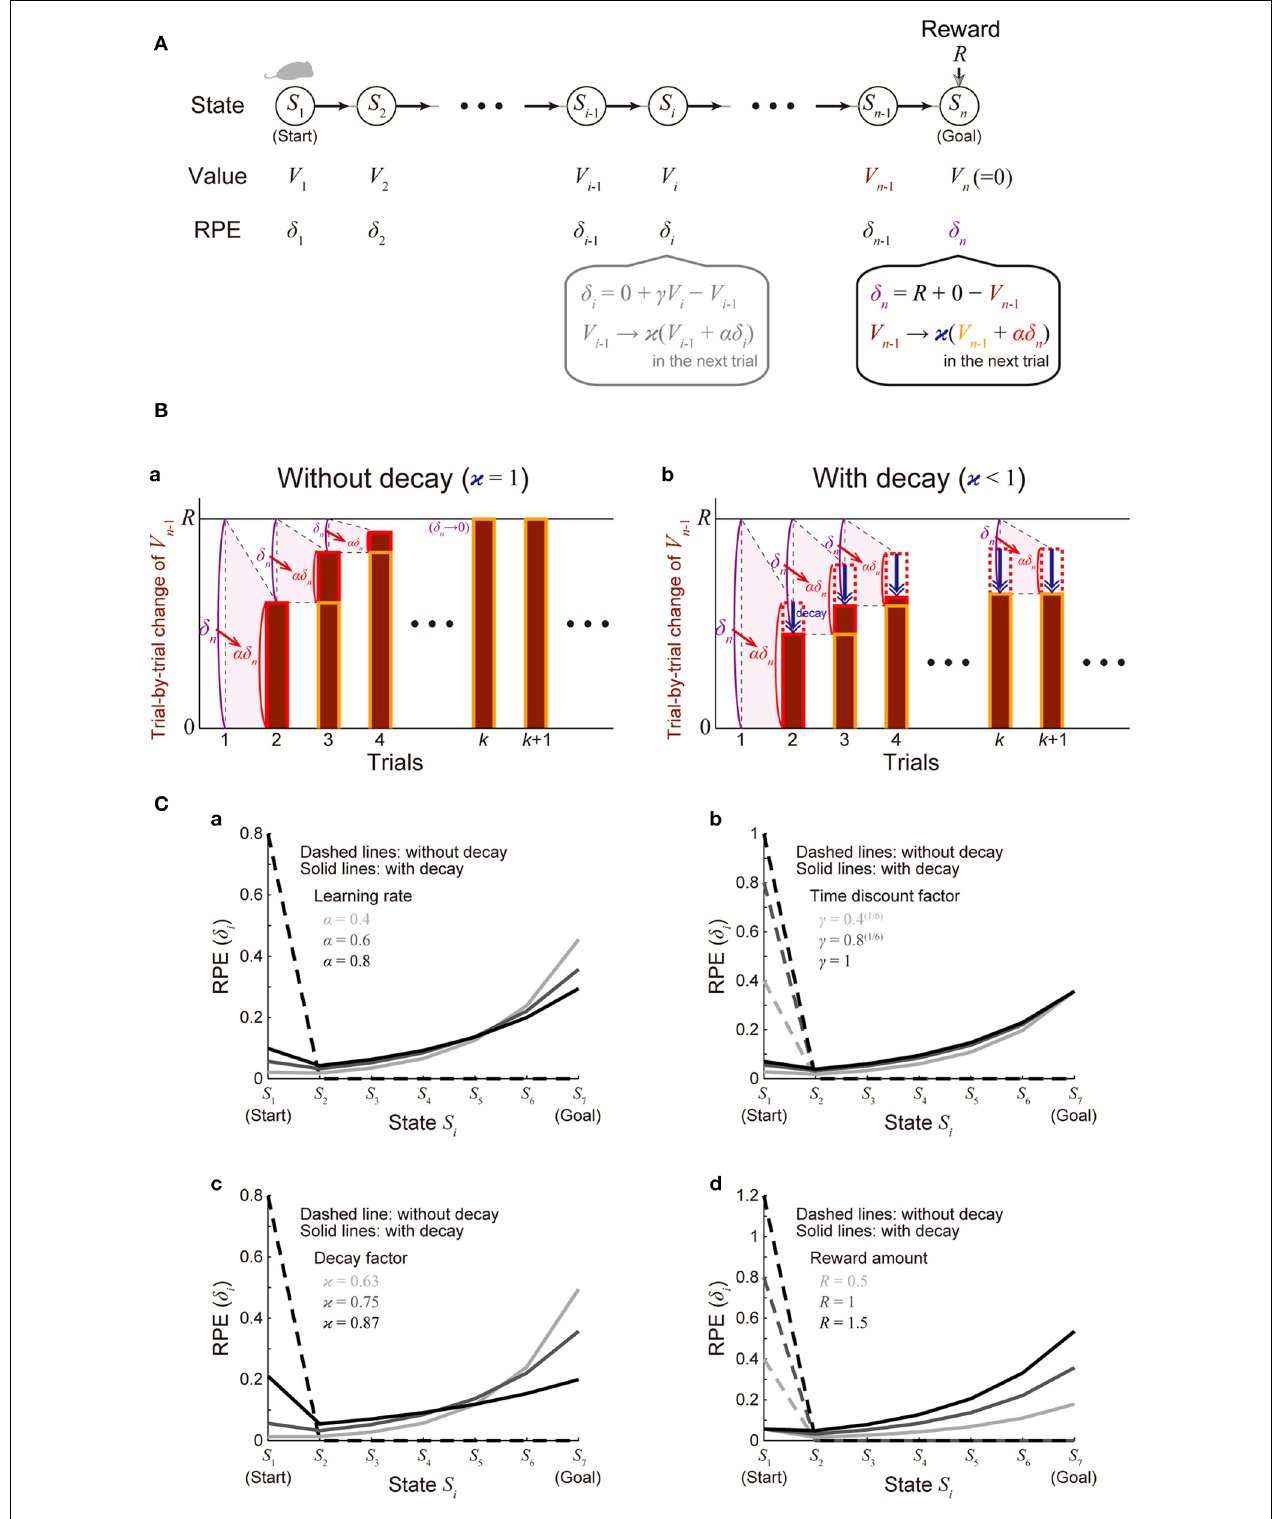
FIGURE 2 | Incorporation of decay of learned values into the reinforcement learning model causes ramping of RPE. (A) Simulated spatial navigation (unbranched “I-maze”) task associated with reward. In each trial, subject starts from S 1 (start), and moves to the neighboring state